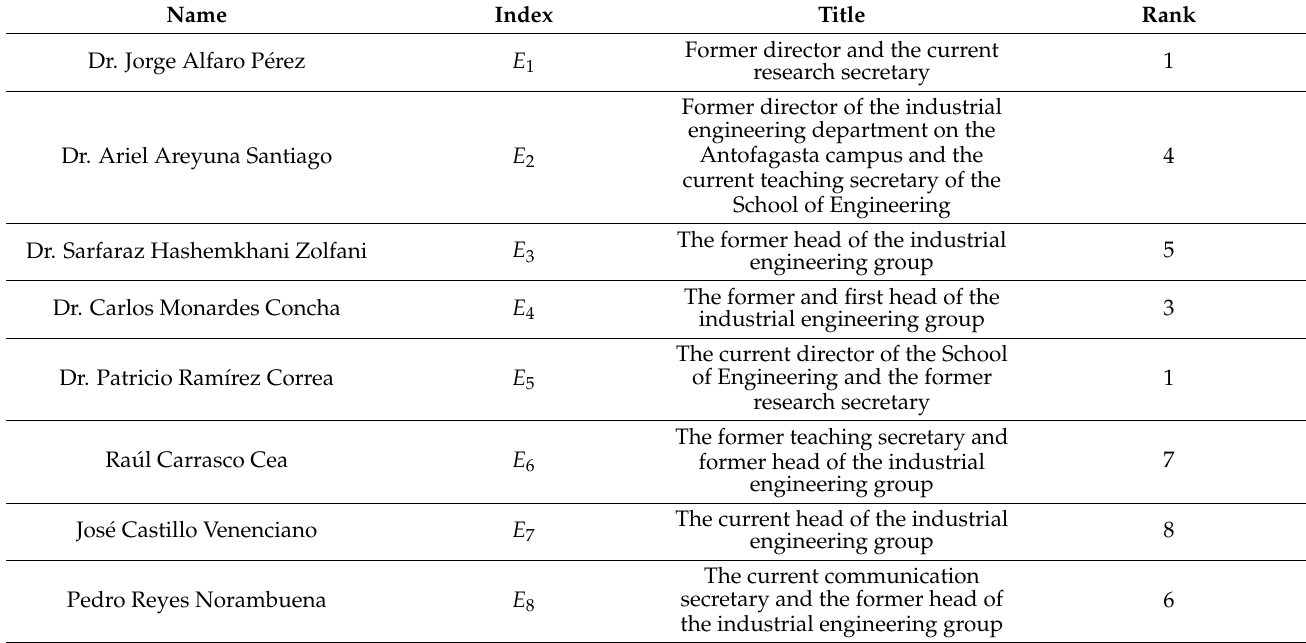
Table 4. Experts introduction and prioritization.